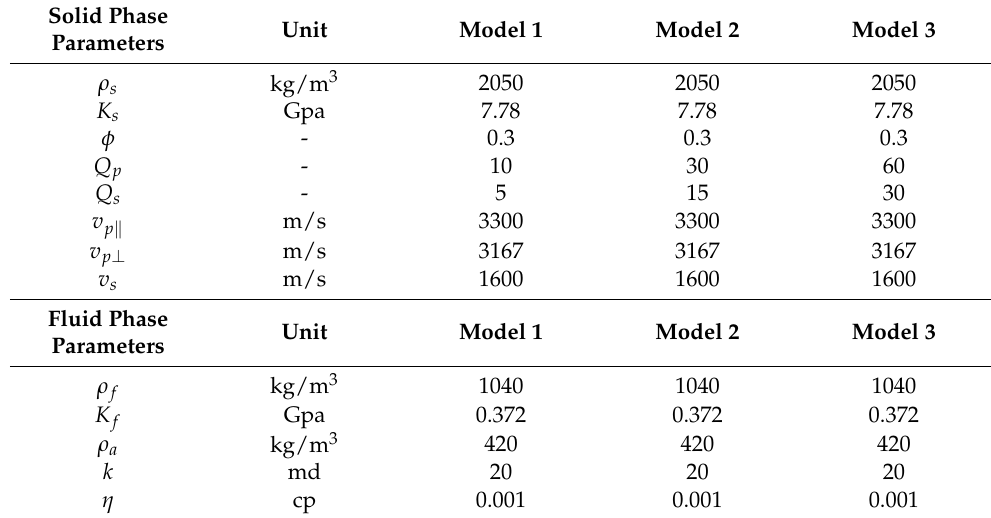
Table 2. Three models with three different quality factor